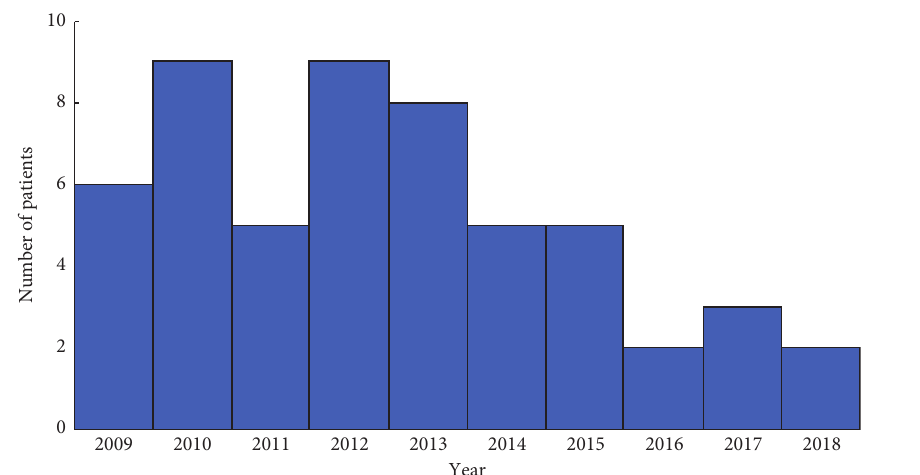
Figure 1: Histogram illustrating number of intraocular foreign bodies per year during the study period.